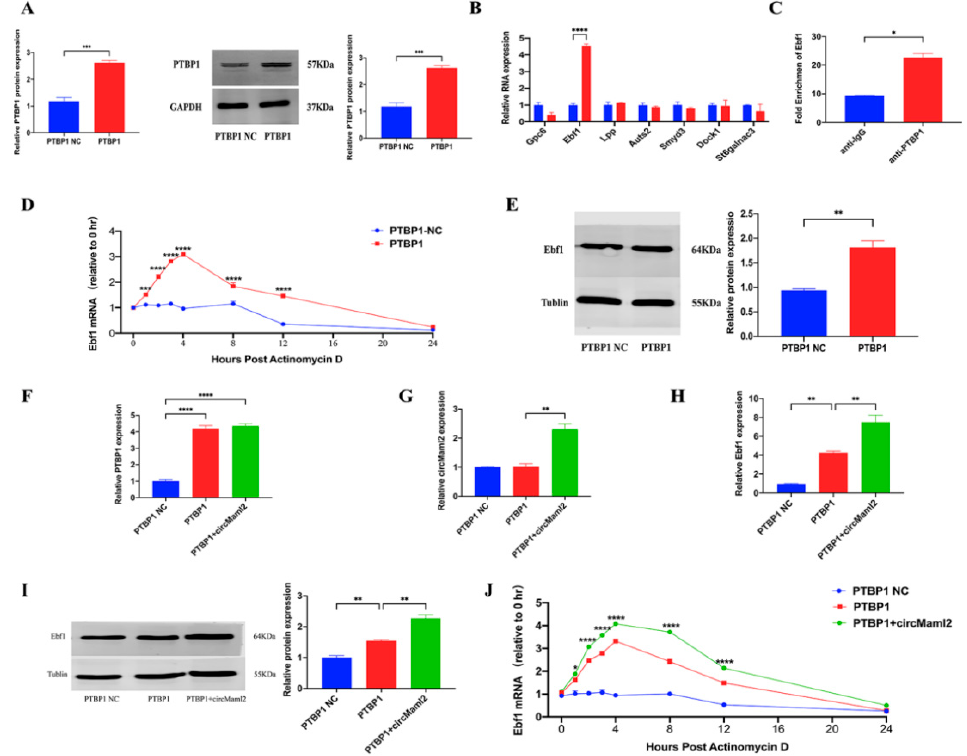
Figure 3. CircMaml2 Enhances PTBP1 to Upregulate Ebf1 Expression. ( A ) Verification of the over- expression of PTBP1 by lentivirus in MC38 cells though qRT-PCR (left) and Western blot (right) (*** p = 0.0008, t test). ( B ) The expression level of downstream target mRNAs after overexpression of PTBP1 (**** p < 0.0001, two-way ANOVA). ( C ) Using anti-IgG and anti-PTBP1 antibodies. The percentage of RIP-enriched PTBP1 and Ebf1 mRNA relative to the input value was calculated by qRT-PCR (* p = 0.0104, t test). ( D ) qRT-PCR was used to measure the expression levels of Ebf1 after actinomycin D treatment in the context of PTBP1 overexpression (*** p = 0.0004, **** p < 0.0001, two- way ANOVA). ( E ) Protein expression of Ebf1 upon PTBP1 overexpression in MC38 cells (** p = 0.0031, t test). ( F , G ) Verification of Ad-circMaml2 in PTBP1 overexpression MC38 cells (**** p < 0.0001,